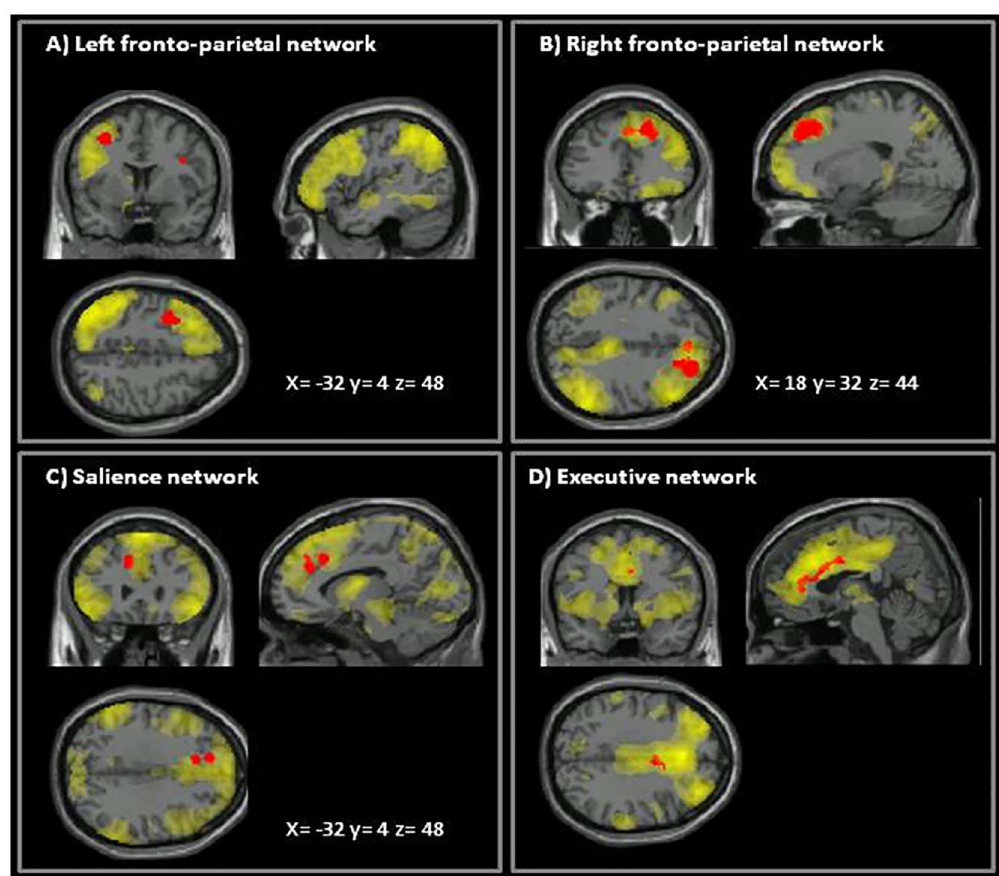
Fig 2. Associations between single network FC and spatial working memory performance in HOM patients. Within each network (shown in yellow), red areas illustrate the brain regions whose functionalconnectivity was positively associated with scores reported by homozygous (HOM) mutation carriers at the Corsi test (spatial working memory). These regions included: the left middle frontal gyrus within the left fronto-parietal network (A); the right superior frontal gyrus within the right fronto-parietal network (B); the left paracingulate gyrus within the salience network (C); and the right anterior cingulategyrus within the executive network